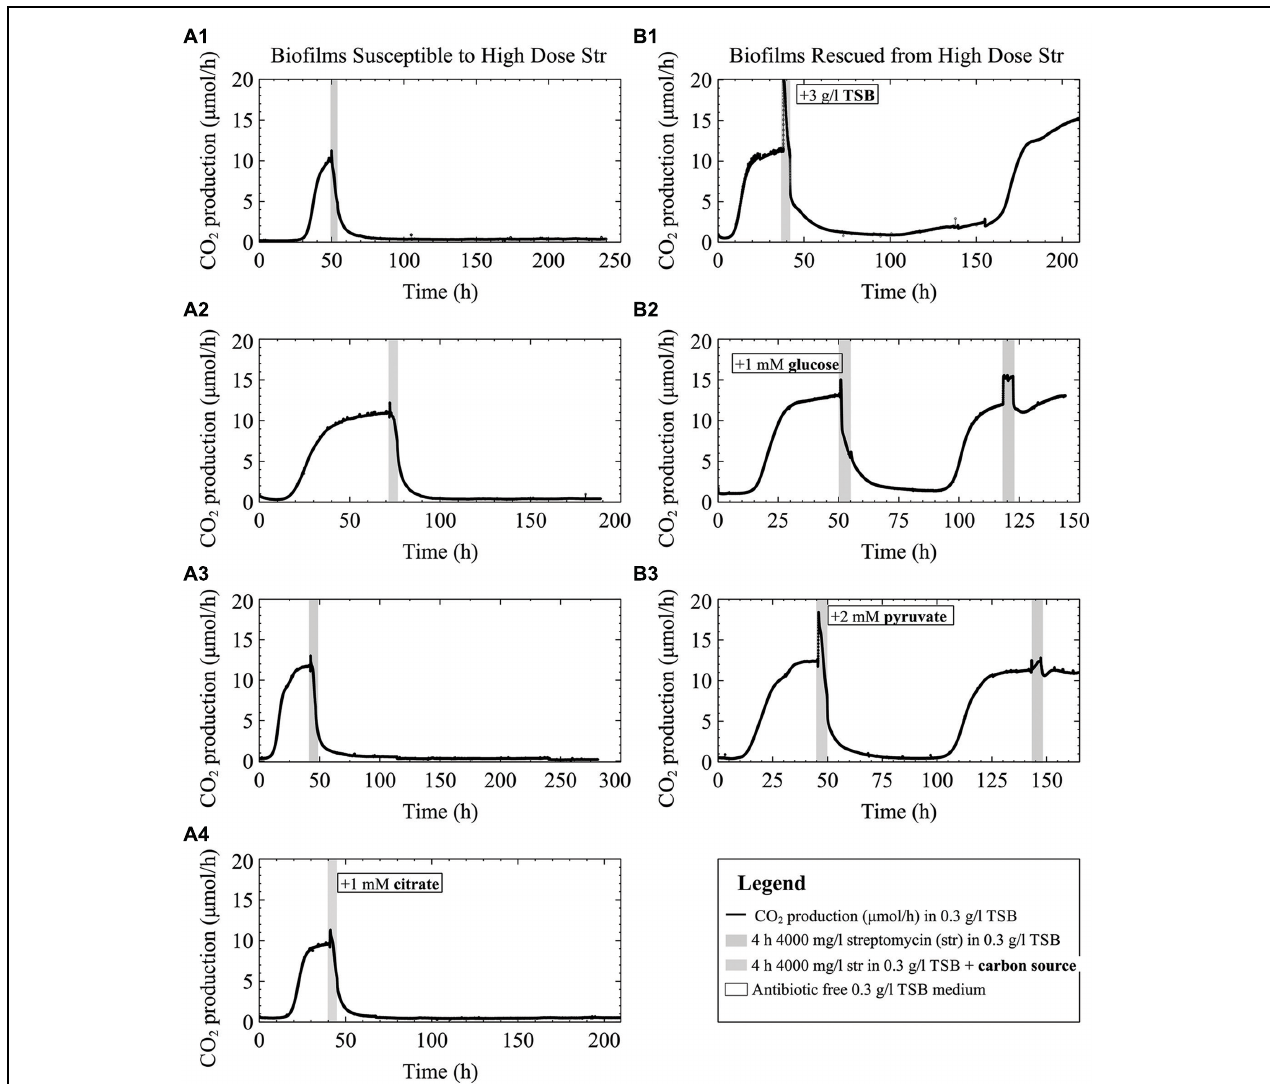
FIGURE 2 | CO 2 production ( µ mol/h) of multispecies biofilms grown on 0.3 g/l TSB medium exposed to 4000 mg/l streptomycin with and without the addition of carbon to the antibiotic medium. Column (A) shows late exponential phase (A1) and early steady state biofilms (A2–A4) exposed to streptomycin. The biofilms were exposed to streptomycin in either 0.3 g/l TSB medium (A1–A3) or 0.3 g/l TSB medium with the addition of 1 mM citrate to the 0.3 g/l TSB antibiotic medium (A4) . Column (B) shows the metabolic response of biofilms that recovered following the high dose streptomycin exposures from the addition